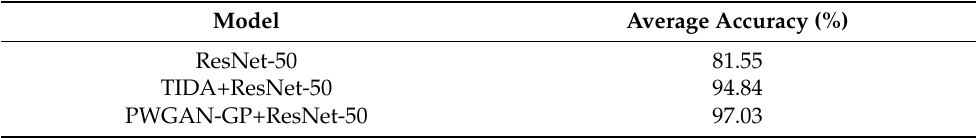
Table 16. ResNet-50 testing in the dataset of complex